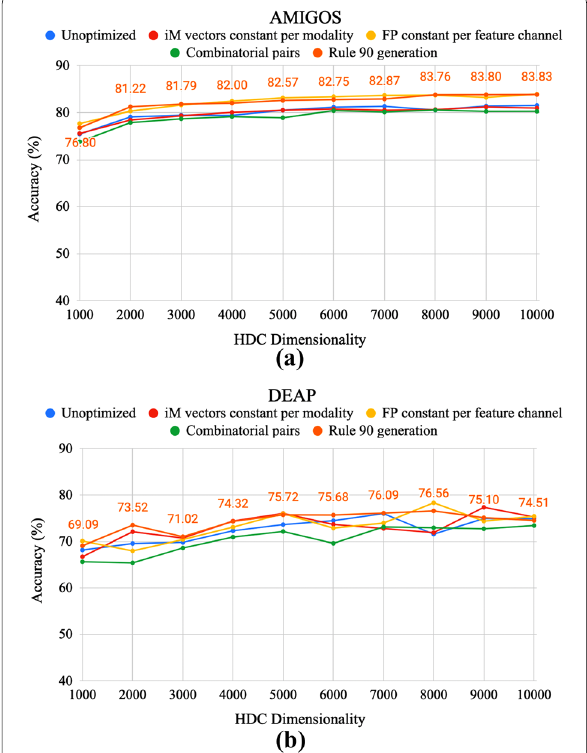
Fig. 9 Average valence and arousal accuracy for the various memory optimizations proposed as the hypervector length decreases for a AMIGOS and b DEAP. The data labels are shown for the most optimized version: rule 90